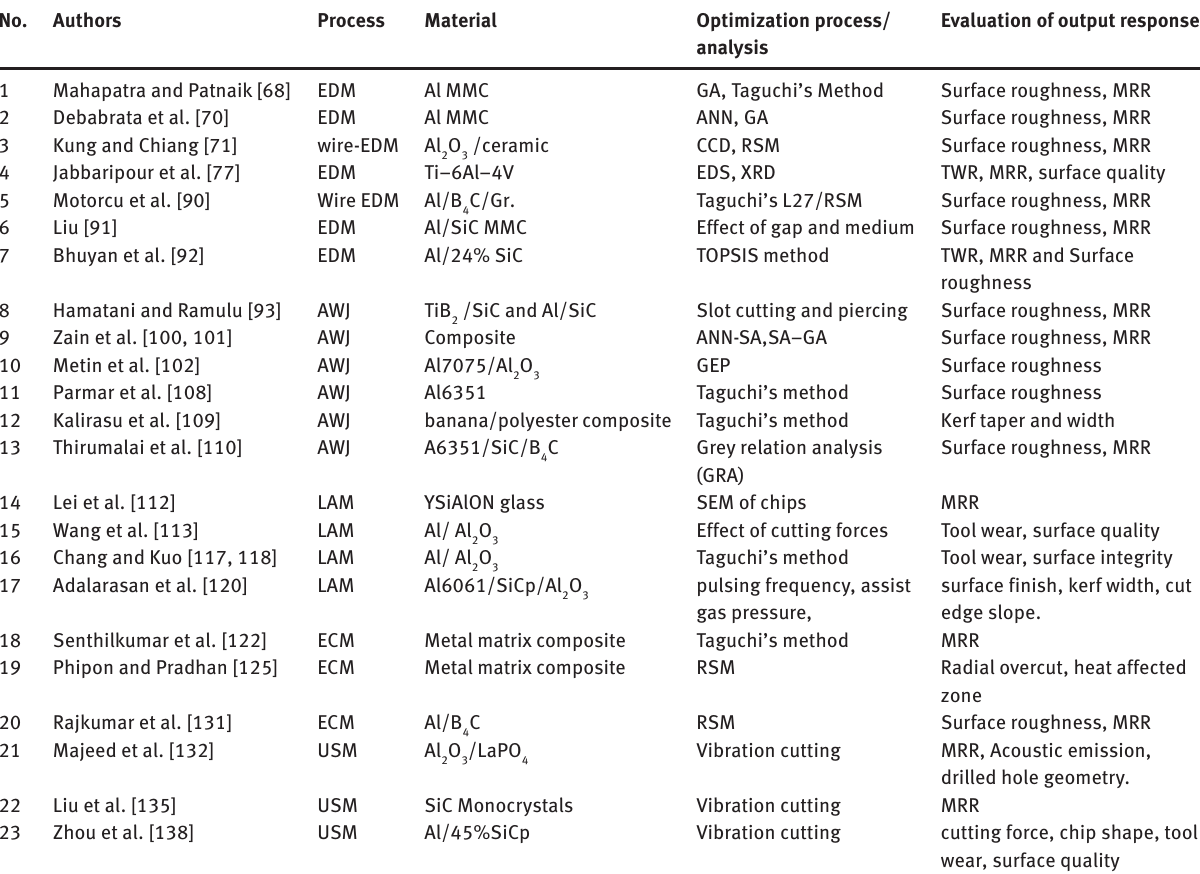
Table 4: Evaluation of non conventional machining of metal matrix composite.